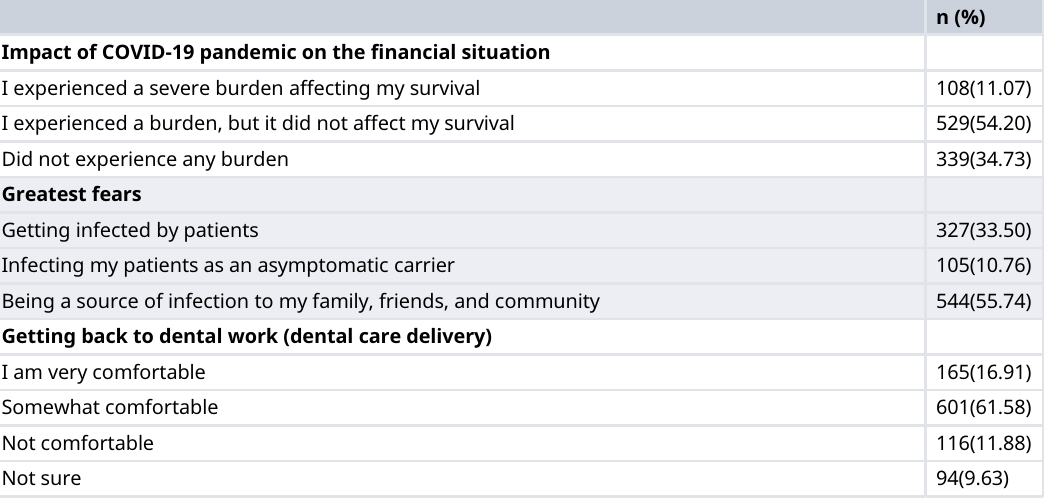
Table 2. The perceptions of the participants concerning returning to work.